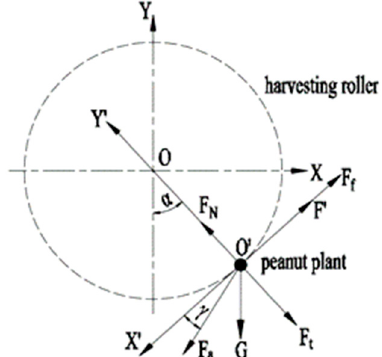
Figure 5. Force diagram of peanuts in harvesting cylinder. α is the angle between the line OO’ and the Y-axis; γ is the angle of the backward inclination of the teeth. F is the centrifugal force, F N is the support force of the gravure sieve, F f is the frictional force of the gravure sieve, F’ is the inertia force in the opposite direction of acceleration, F a is the force of the spring teeth on the peanut pods, and F t is centrifugal force.